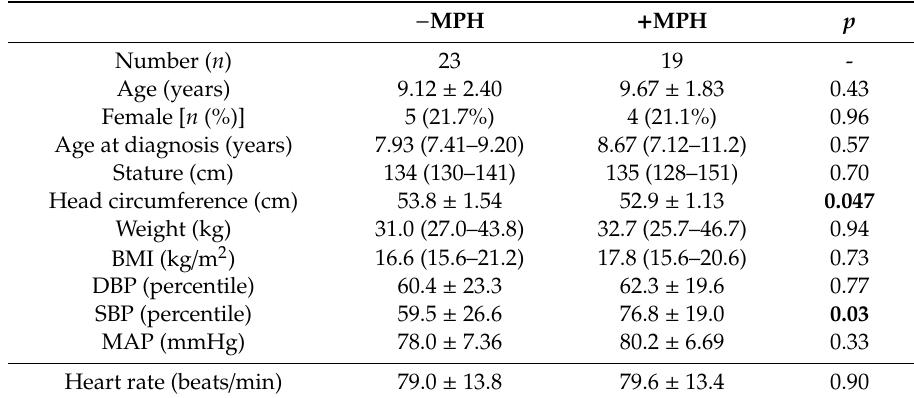
Table 1. Anthropometric characteristics of the attention deficit hyperactivity disorder (ADHD) children without ( − MPH) and with ( + MPH) methylphenidate (MPH)